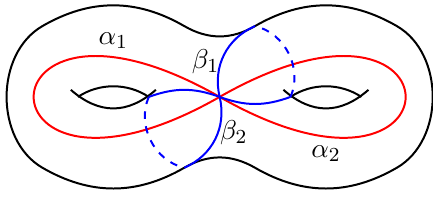
Figure 2 . The choice of homology basis of the Riemann surface for the example g = 2.